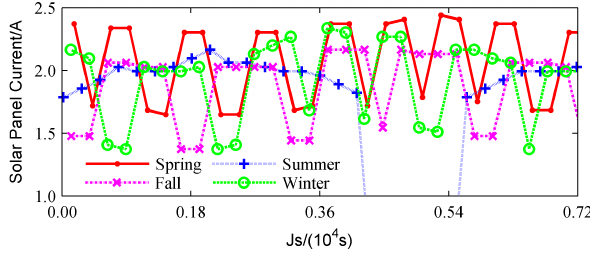
Figure 4. Current telemetry values of solar array